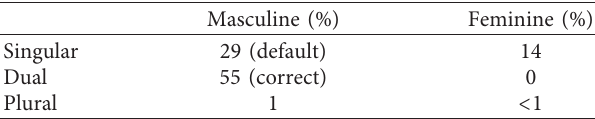
Table 4: Adjective number and gender responses (target noun is masculine).